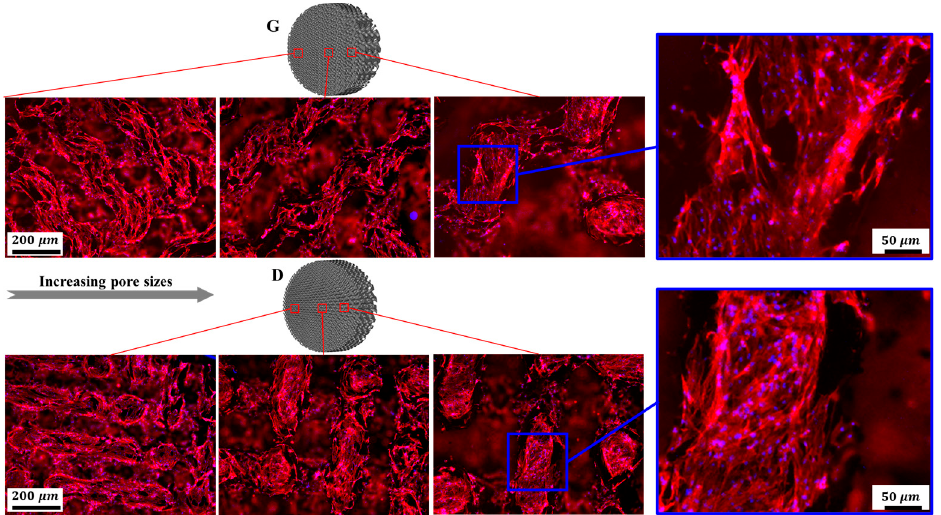
Figure 15. Representative fluorescence images of osteoblasts adhering to Gyroid and Diamond scaffolds with consecutive gradient in cell-sizes ranging from 0.6 to 2 mm . Cells were stained with actin filament (red), cell nuclei (blue).